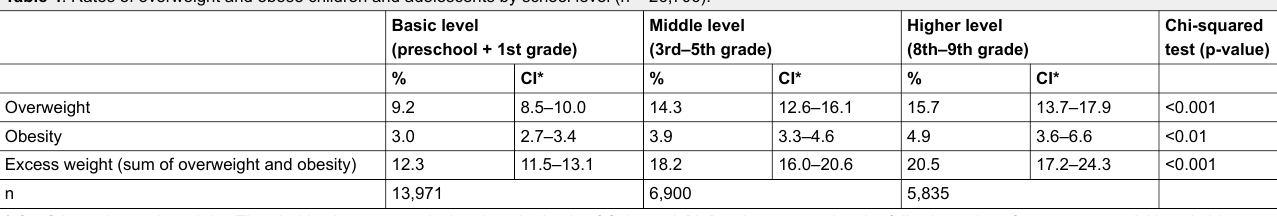
Table 4 : Rates of overweight and obese children and adolescents by school level (n =